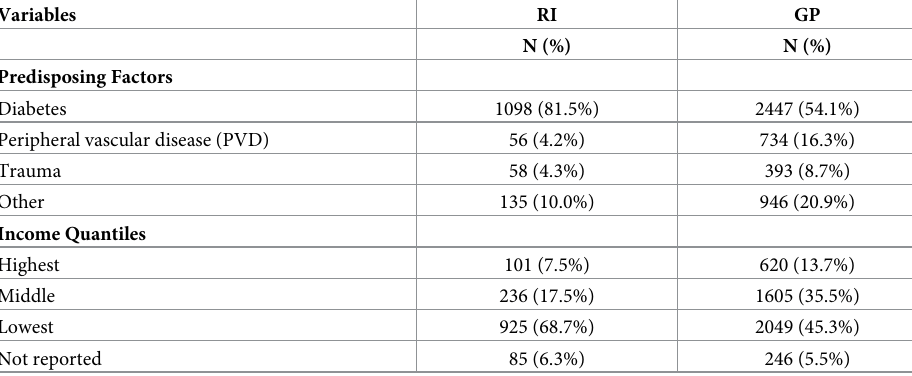
Table 1. Characteristics of amputation predisposing factors and income quintiles.